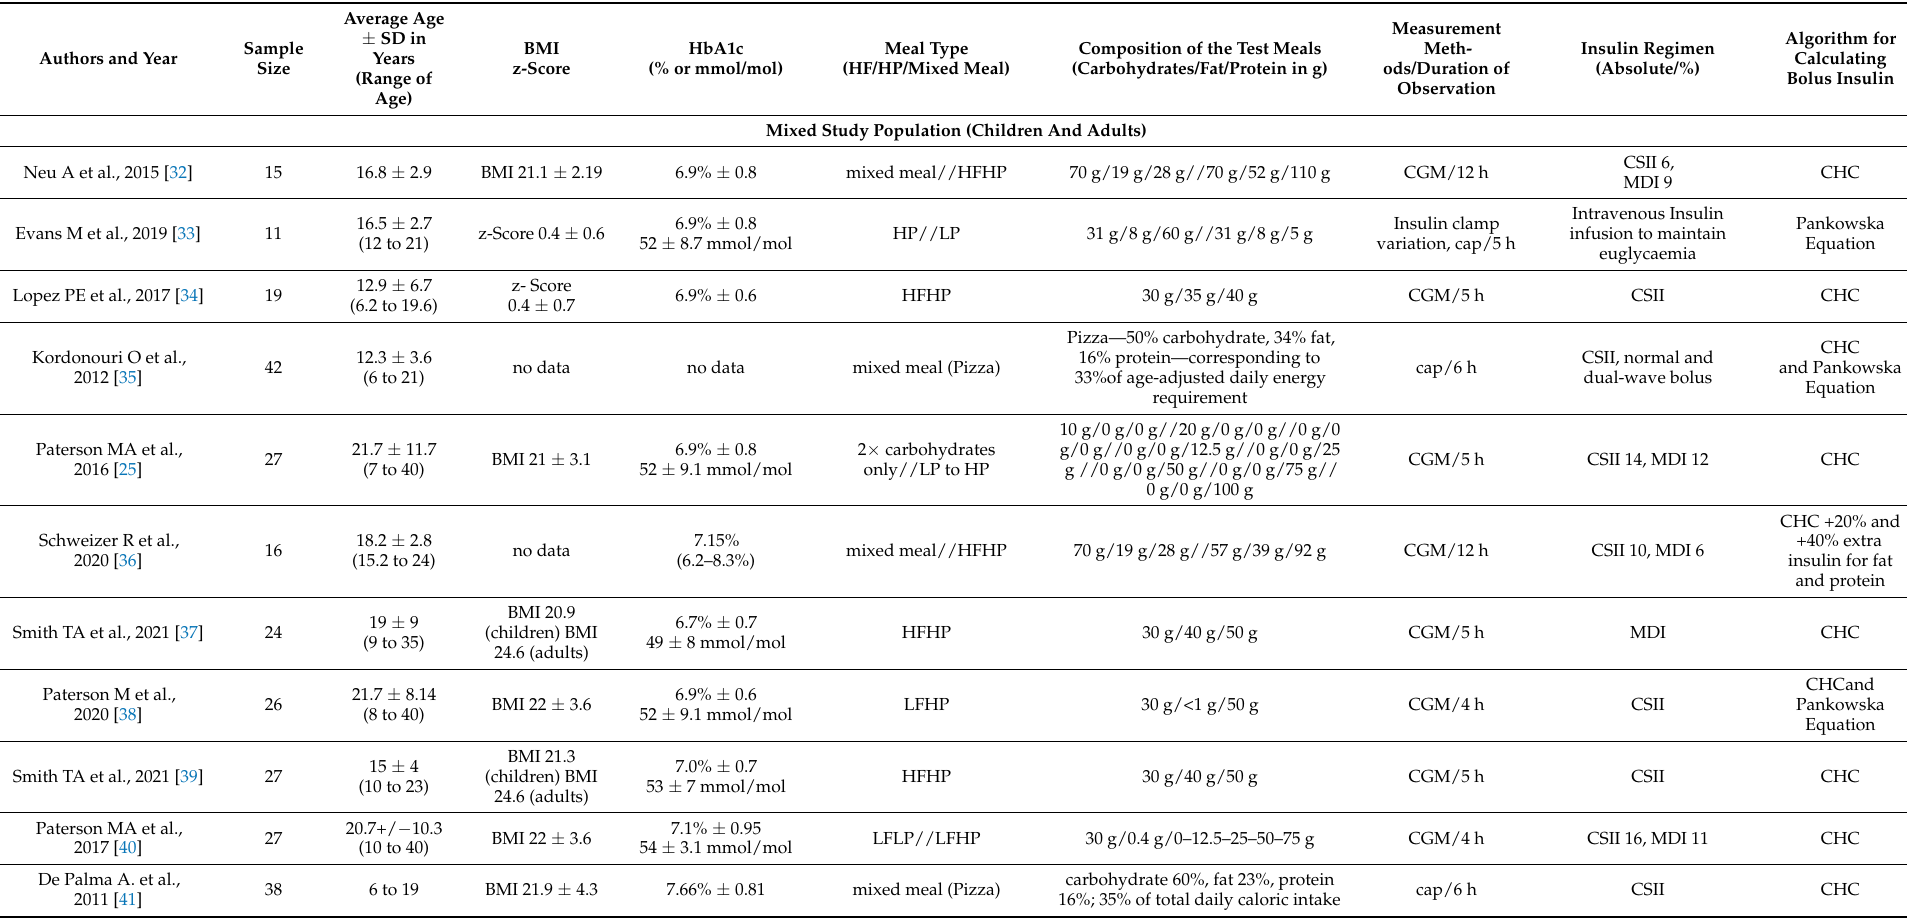
Table 2. Reviews for mixed study population between 1 January 2011 and 1 May